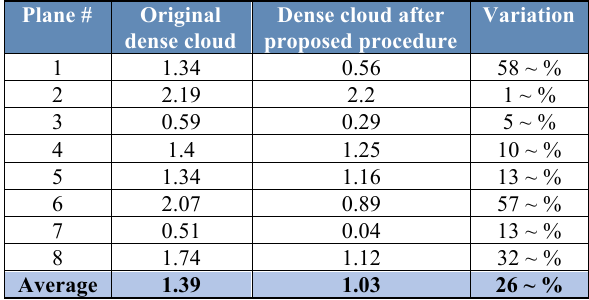
Table 3: Plane fitting RMSE (cm) and variations on eight selected planar areas (Fig. 8), computed on the original and the post-filtering dense point